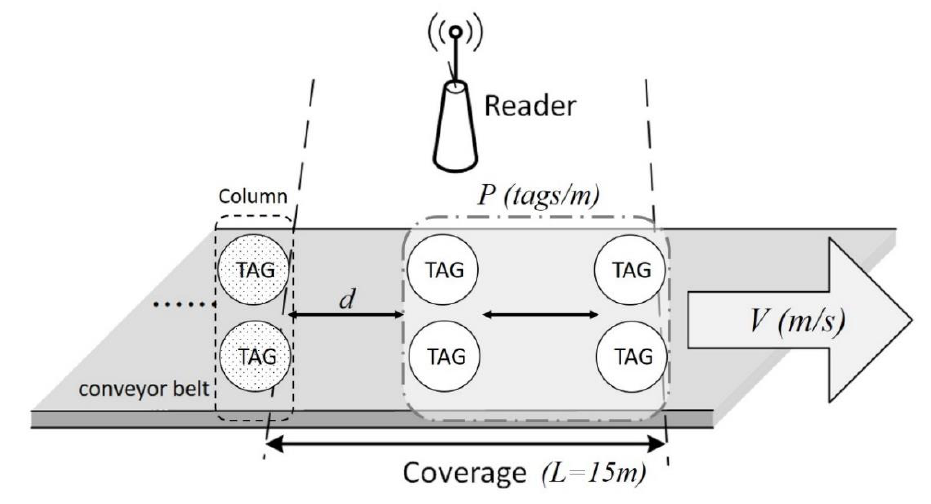
Figure 12. Simulated environment.